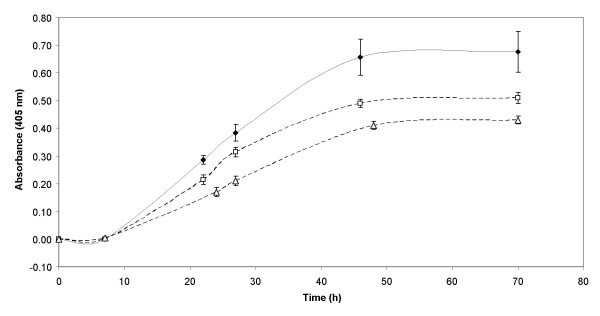
Effect of cinnamaldehyde and 2-NO2-cinnamaldehyde on the pigment production of Vibrio anguillarum LMG 4411. Cinnamaldehyde and 2-NO2-cinnamaldehyde were tested at 100 μM. Vibrio anguillarum LMG 4411 was allowed to produce pigment in the absence (solid symbol) or presence of cinnamaldehyde (open symbol, square) or 2-NO2-cinnamaldehyde (open symbol, triangle). Three ml samples were taken at multiple time points. The effect of cinnamaldehyde or 2-NO2-cinnamaldehyde on pigment production was estimated by measuring the absorbance at 405 nm. The error bars represent the standard deviation.